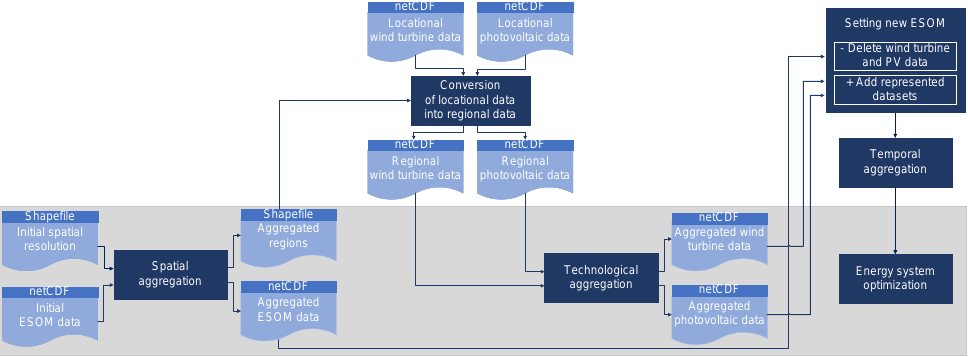
Figure 3. Block diagram depicting the general workflow adopted. The blocks highlighted with a gray background are the focus of this